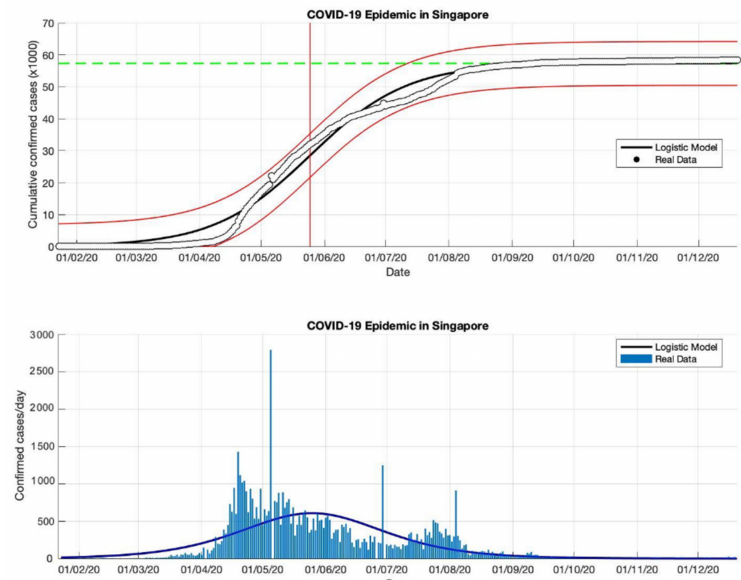
Figure 7. In the above figure, the prediction results of the logistic growth model for cumulative infected cases are compared with the actual data, while the two red lines between the black lines represent a prediction error limit of about 5%. The dashed green line predicts the total size of infected cases in the final phase of the epidemic. The red line intersects the cumulative case curve to predict the turning point or peak point of the epidemic (this line is parallel to the top of the curve from the below figure). In the below figure, the prediction results of this model for daily infected cases